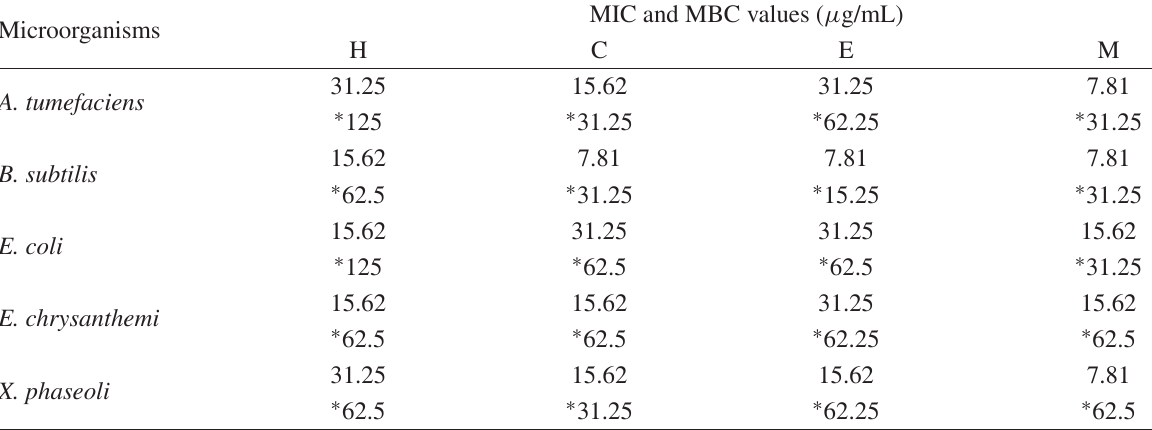
TABLE 2: Minimum inhibitory/bactericidal concentration ( µ